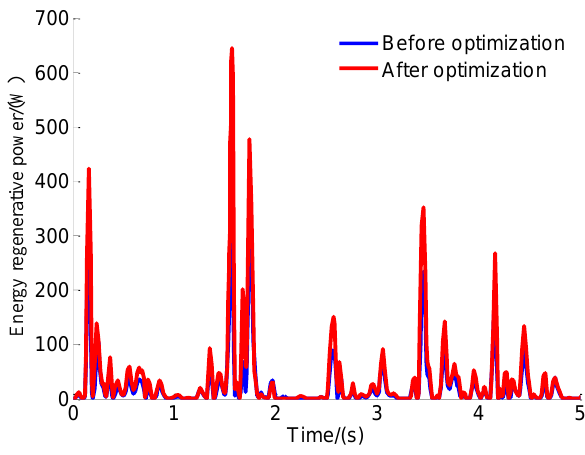
Figure 11. Energy regenerative power response curve.